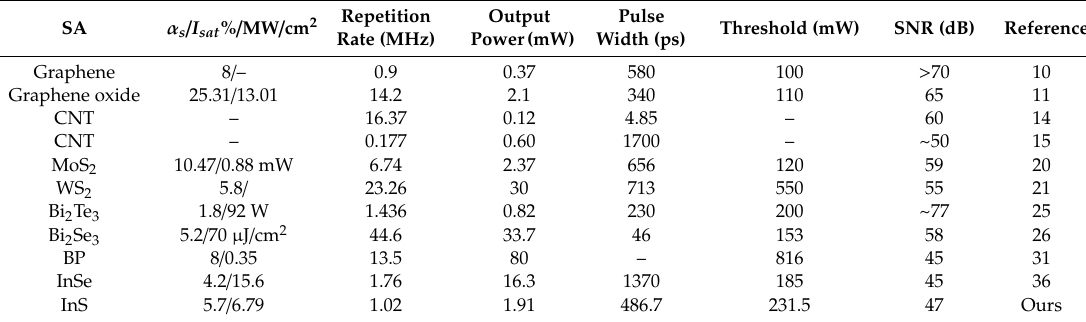
Table 1. Comparison of Yb-doped mode-locked lasers incorporating di ff erent SAs.